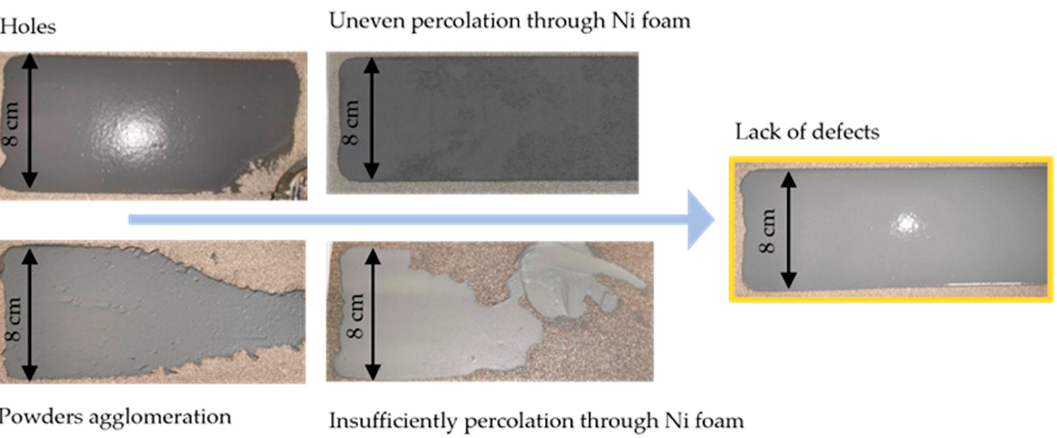
Figure 5. Types of defects occurring during Ni-SDC cathode optimization.